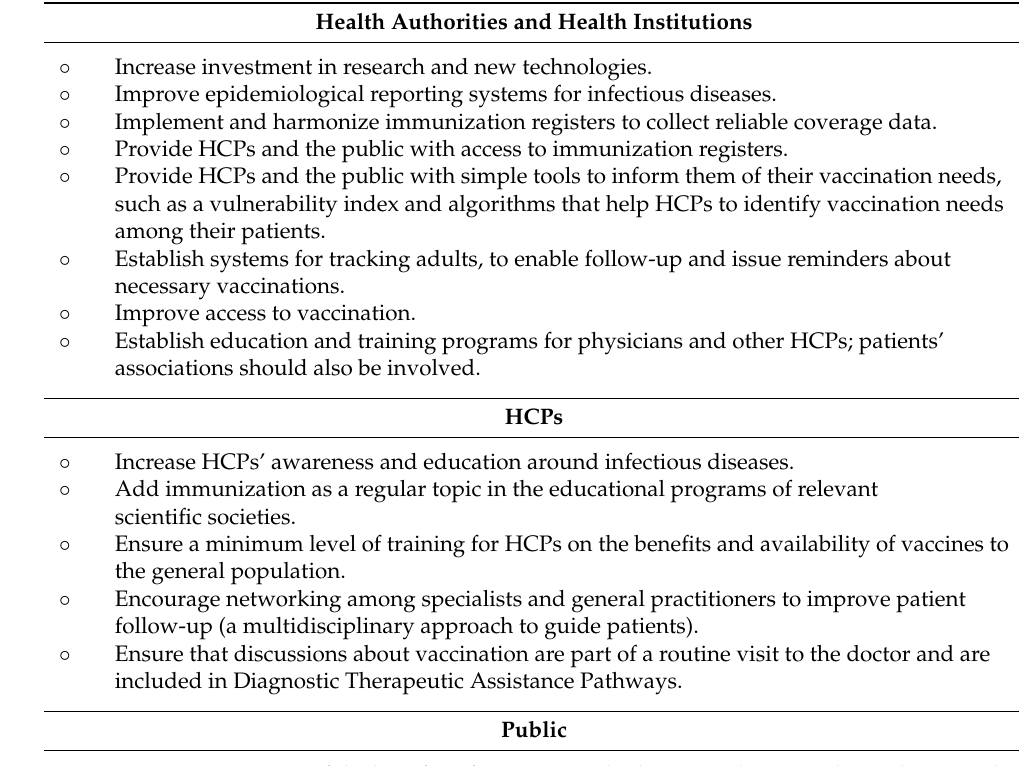
Table 1. Calls to action for each group of stakeholders involved in the process of